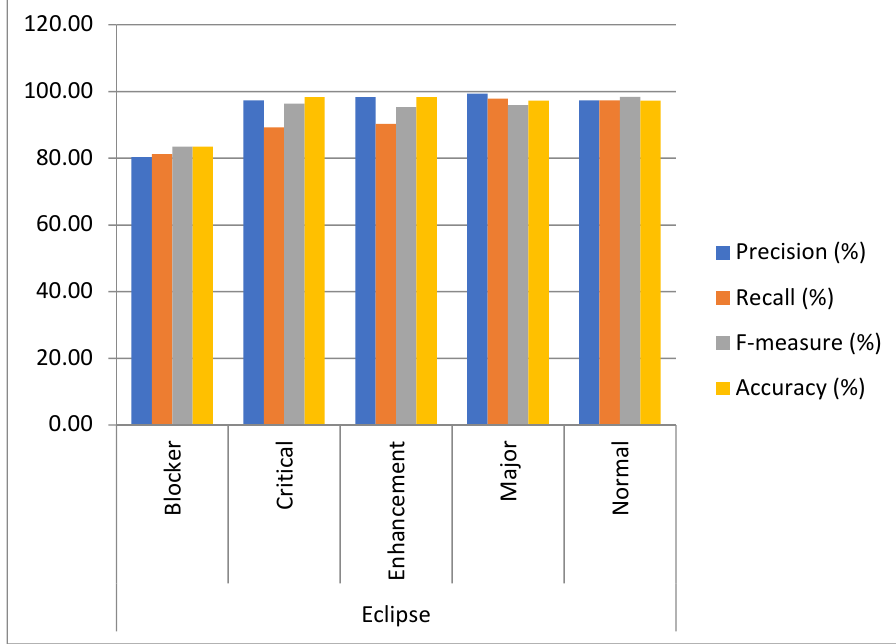
Figure 7. Results analysis of the proposed BCR on seven classes of the Eclipse Project .